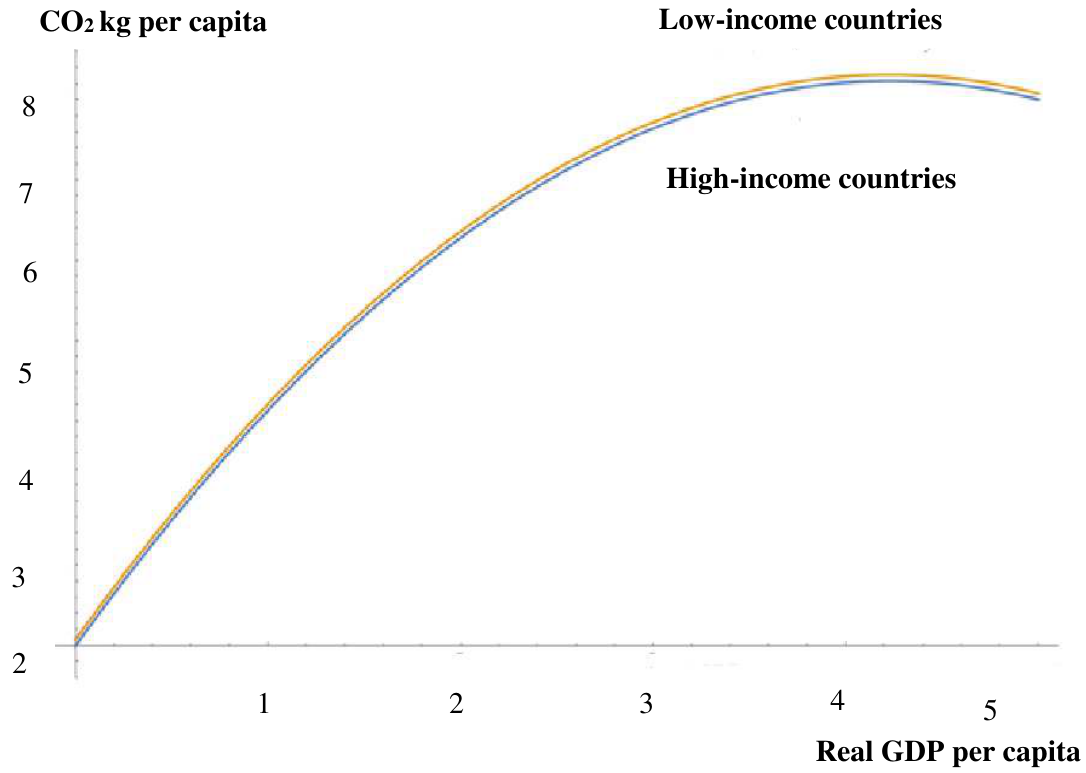
Fig. 3. Comparison of CO 2 emissions for high- and low-income countries in